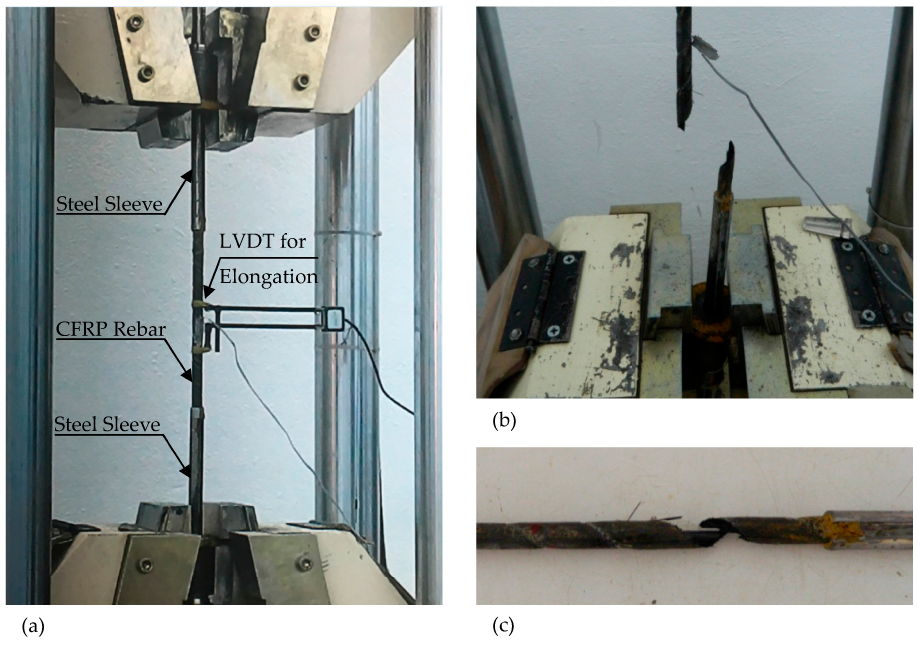
Figure 3. Rebar rupture test. ( a ) Test setup; ( b ) End of test; ( c ) Location of rupture.